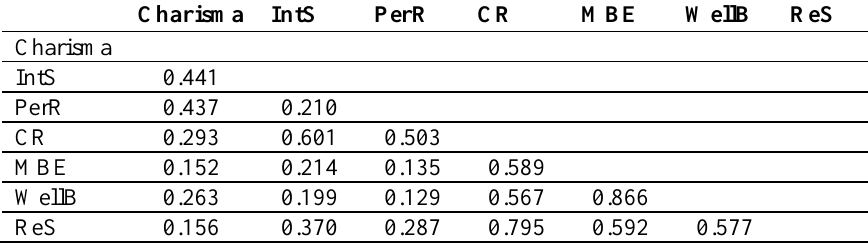
Table.2. HTMT Ratios (good if < 0.90, best if < 0.85)